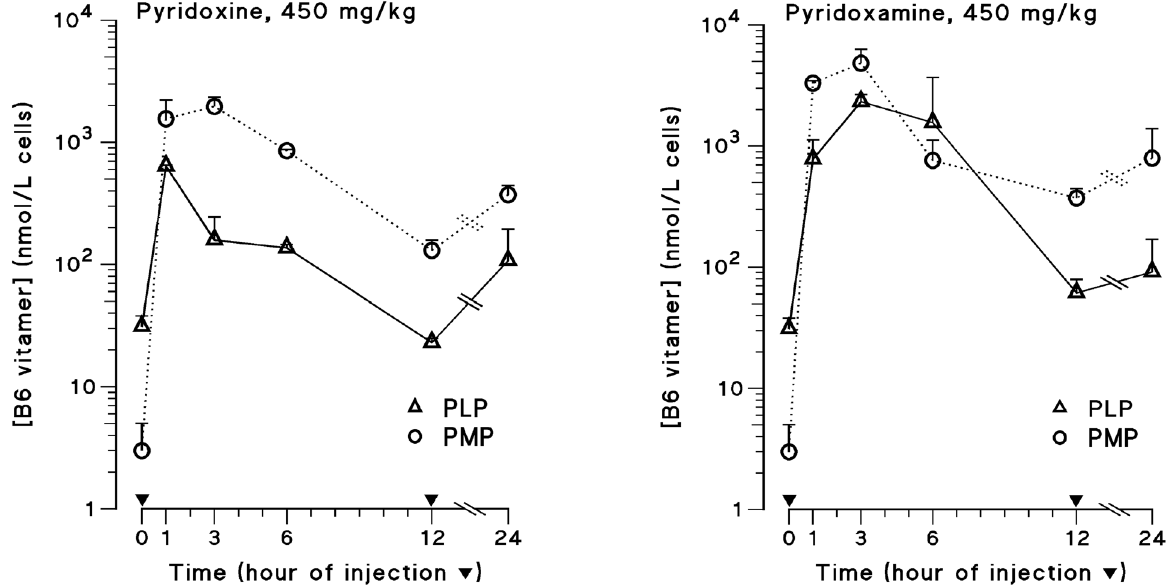
Figure 2. Erythrocyte pharmacokinetics of B6 vitamers after parenteral administration of high-dose pyridoxine or pyridoxamine in mice. Mouse erythrocyte levels of pyridoxamine 5’-phosphate (PMP; open circles), and pyridoxal 5’-phosphate (PLP; open triangles) were measured after intraperitoneal high-dose pyridoxine (PN) or pyridoxamine (PM). BALB/c mice were given PN or PM at 450 mg/kg at time 0 only, or twice at time 0 and after 12 h from start. For each unphosphorylated B6 vitamer explored, measurements of PMP and PLP were done after 1, 3, 6, 12, and 24 h from start of the experiment. Vertical bars indicate S.E. Table below indicates erythrocyte PLP peak concentration levels and PLP area under the concentration vs time curve in 12 h from injection. PN, 450 mg/kg i.p. PM, 450 mg/kg Intracellular pharmacokinetics parameter